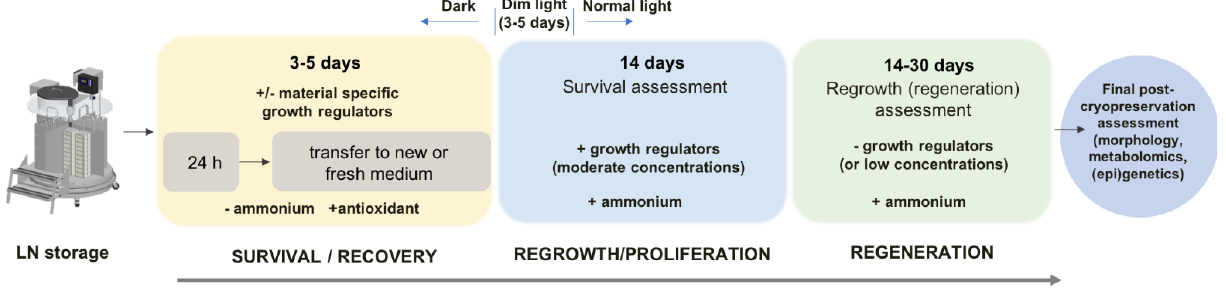
Figure 2. Potential combinations of various strategies at the post-LN steps for plant materials sensi- tive to cryopreservation-induced stresses. LN — liquid